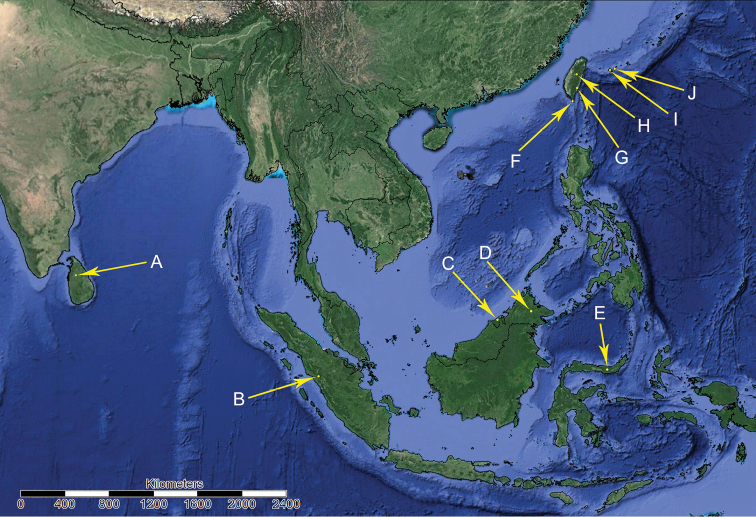
Distribution of Gigantometopini: AI.
lieweniBG.
rossiCG.
schuhi and B.
simulansDP.
luteusES.
henryiFA.
formosanusGK.
yangiHA.
formosanus and I.
lieweni nec IA.
gryllocephalusJA.
gryllocephalus and K.
fraxini